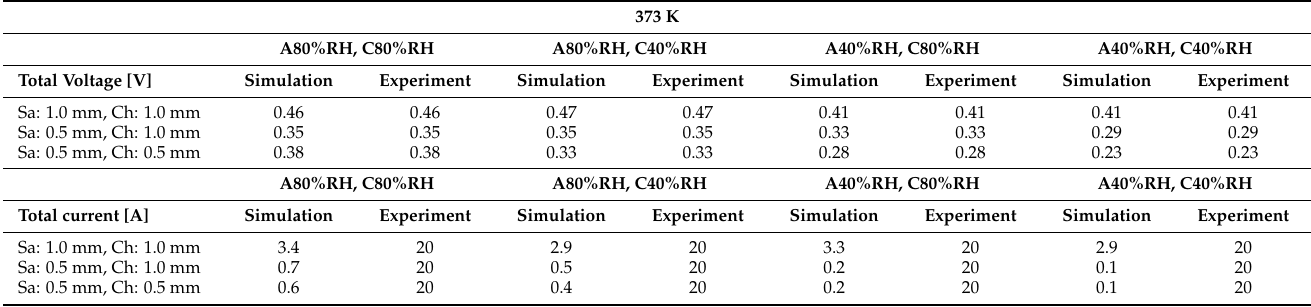
Table 9. Comparison of total voltage and total current between the numerical simulation in this study and the authors’ previous experimental study at 373 K